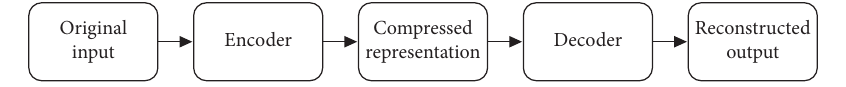
Figure 1: AE structure diagram.